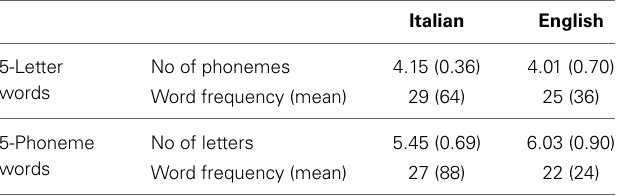
Table 2 | Characteristics of Italian and English 5-letter and 5-phoneme words in Experiment